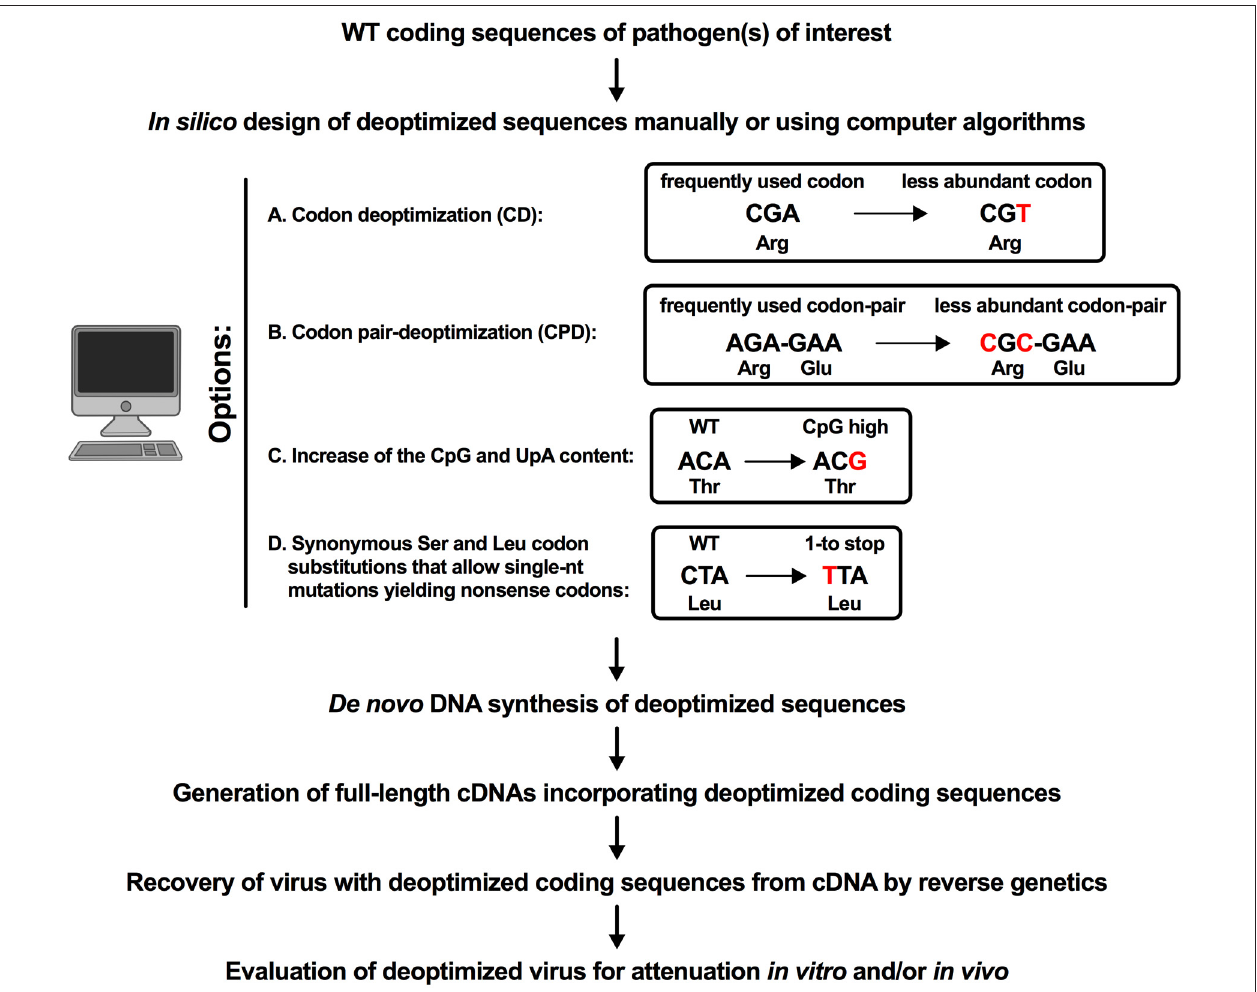
FIGURE 1 | Methodology used to generate genome scale deoptimized RSV or IAV viruses. Four strategies of deoptimization have been used to atttenuate RSV and IAV: (A) codon deoptimization (CD), (B) codon-pair deoptimization (CPD), (C) increase of the CpG and UpA content and (D) synonymous Serine and Leucine codon substitutions that allow single-nt mutations yielding non-sense codons. An example is shown for each approach. The synonymous mutations generated by the deoptimization process are indicated in red. In (A) , the “A” to “T” mutation resulted in the introduction of an underrepresented Arg codon (10). In (B) , the CPD process (37) may yield CpG dinucleotides at codon boundaries that were shown to be significantly suppressed in wt viruses (36). In (C) , the program “Sequence Mutate” in the SSE package (43) introduces a synonymous mutation (“A” to “G”) that resulted in the introduction of a CpG motif in the Thr amino acid. Finally in (D) , a synonymous mutation “C” to “T” generated a Leu codon “TTA” that by only a single-nucleotide change can generate a stop codon (TAA or TGA) (15).